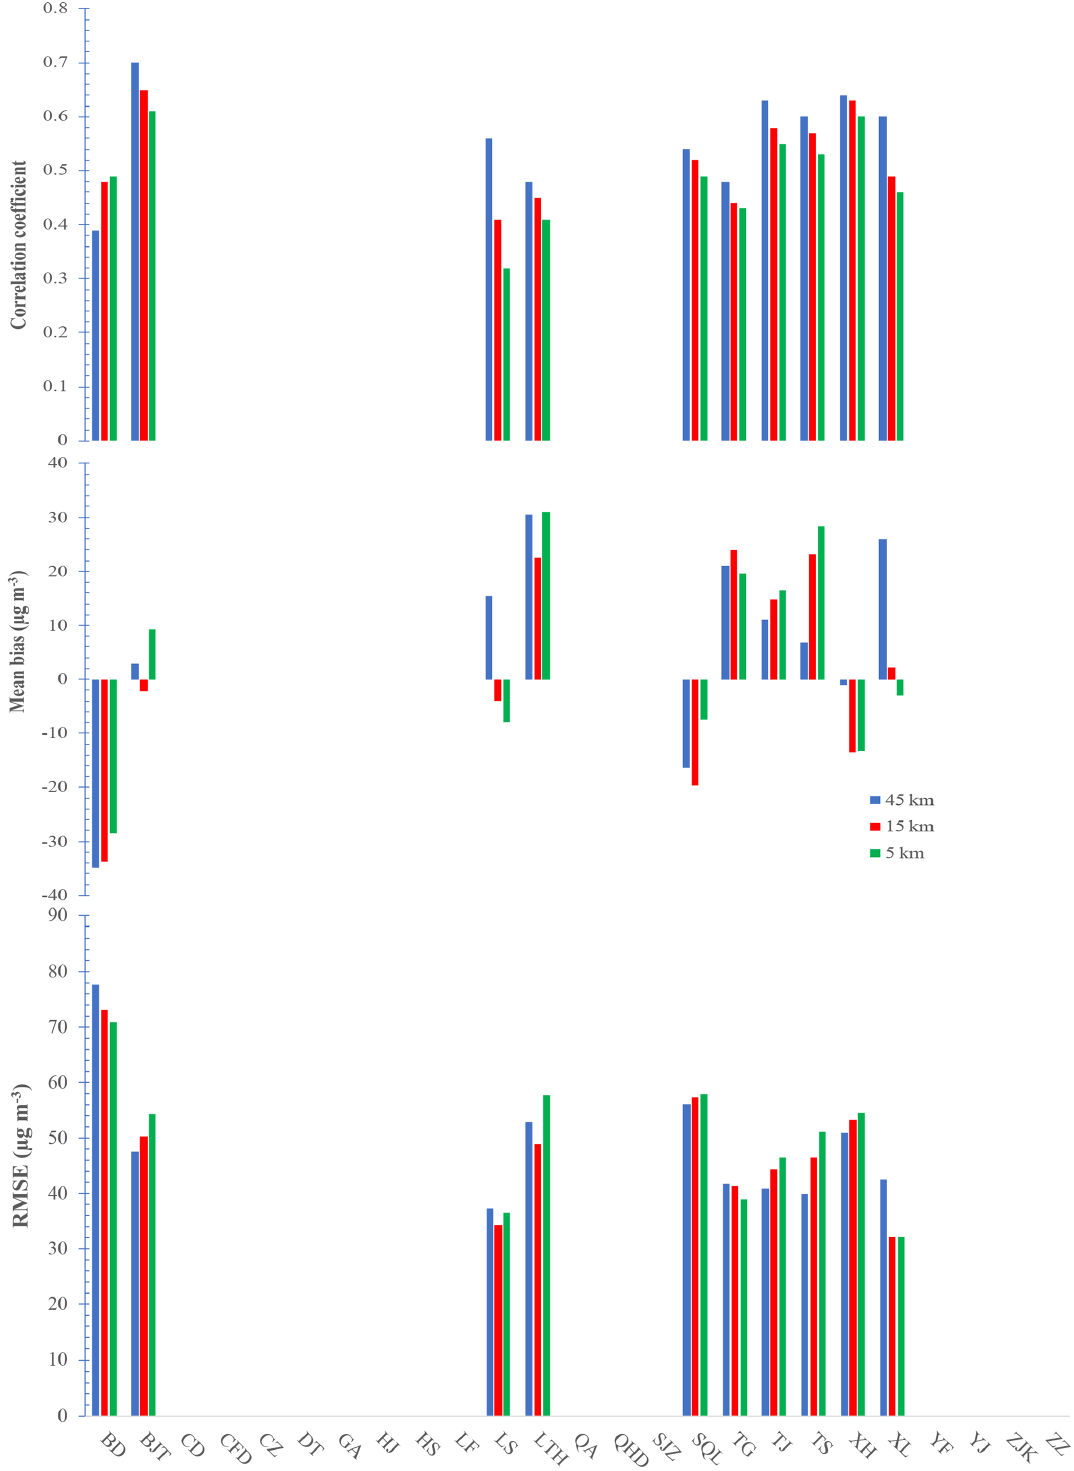
Figure 4. Comparisons of MB, RMSE, and correlation coefficient r of surface PM 2 . 5 from different horizontal resolutions at each air quality monitoring site (blank space indicates no data are available) for the year of